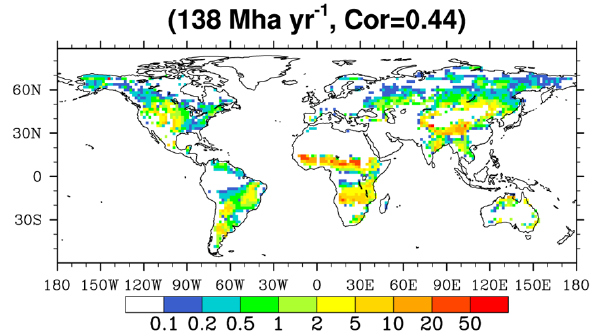
Fig. 15. Spatial distribution of 1997–2004 mean annual burned area fraction (%yr − 1 ) simulated by CLM-DGVM, using the new fire parameterization but estimating fire occurrence probability (i.e. as- suming fire counts calculated in Eq. (2) no more than 1counth − 1 ). Mean annual global burned area and global spatial correlation (Cor) are also